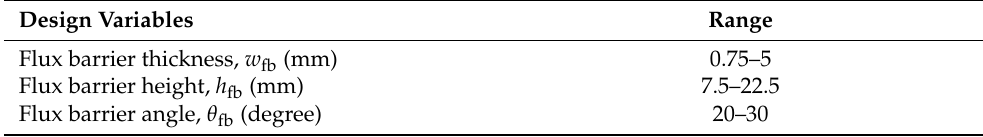
Table 2. Range of design